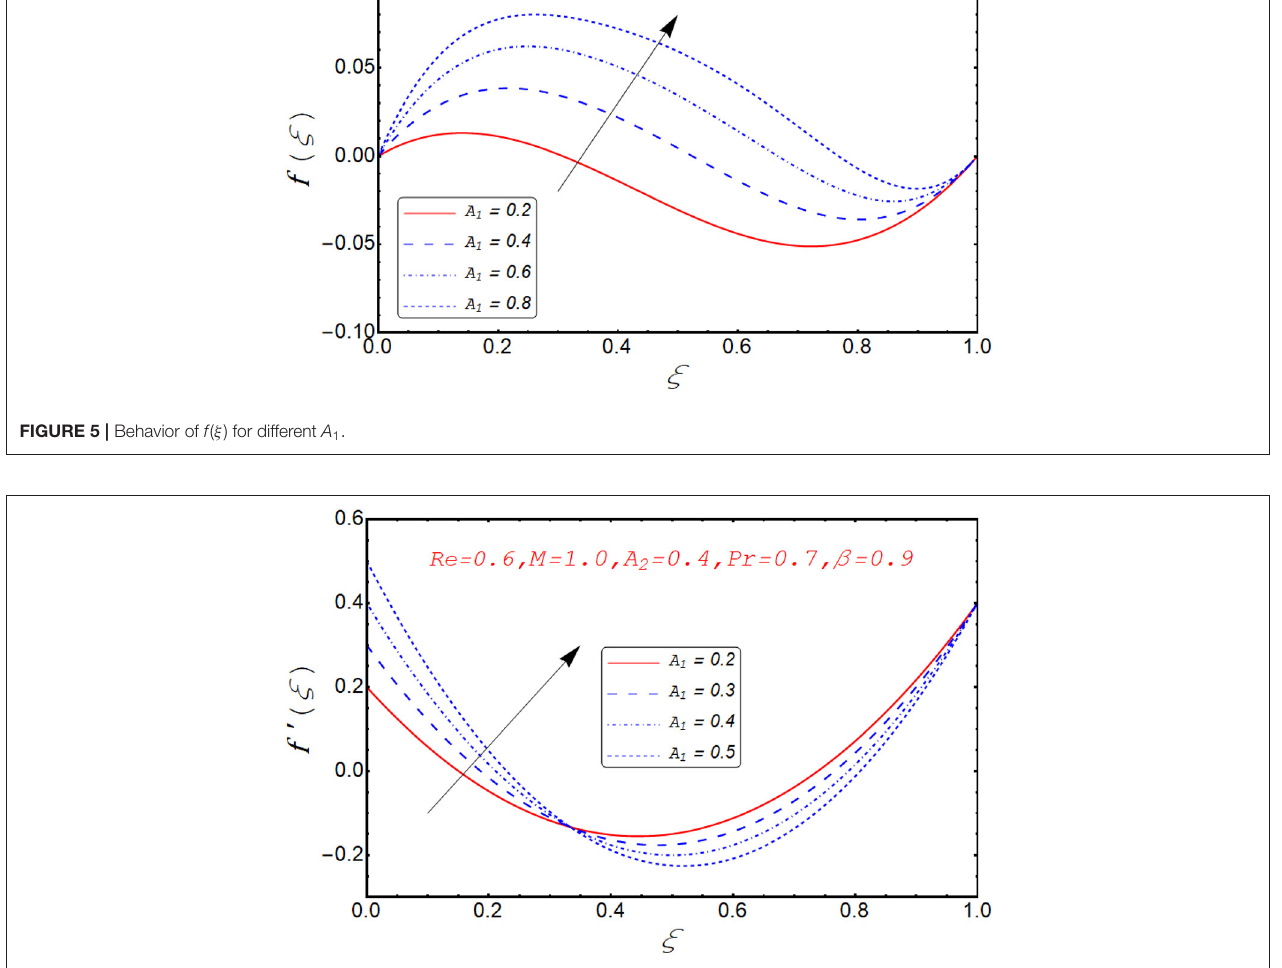
FIGURE 6 | Behavior of f ′ ( ξ ) for different A